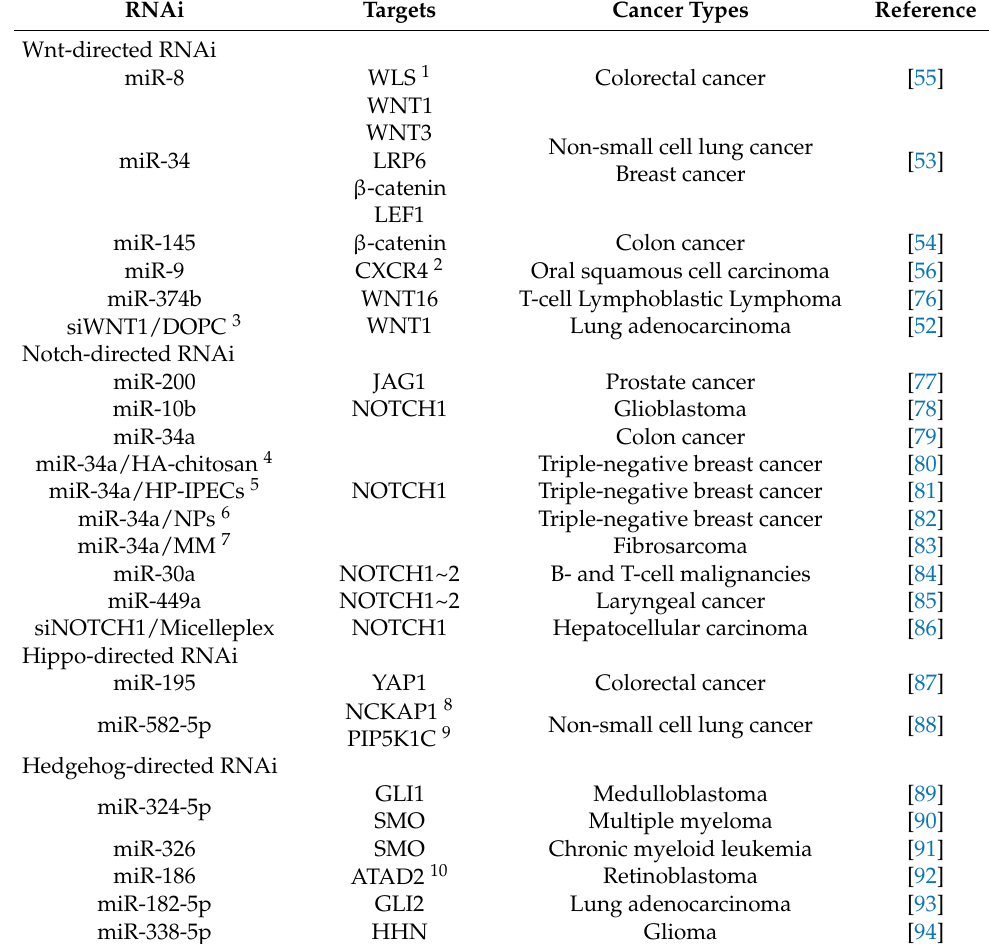
Table 1. Investigational RNAi therapeutics targeting CSC